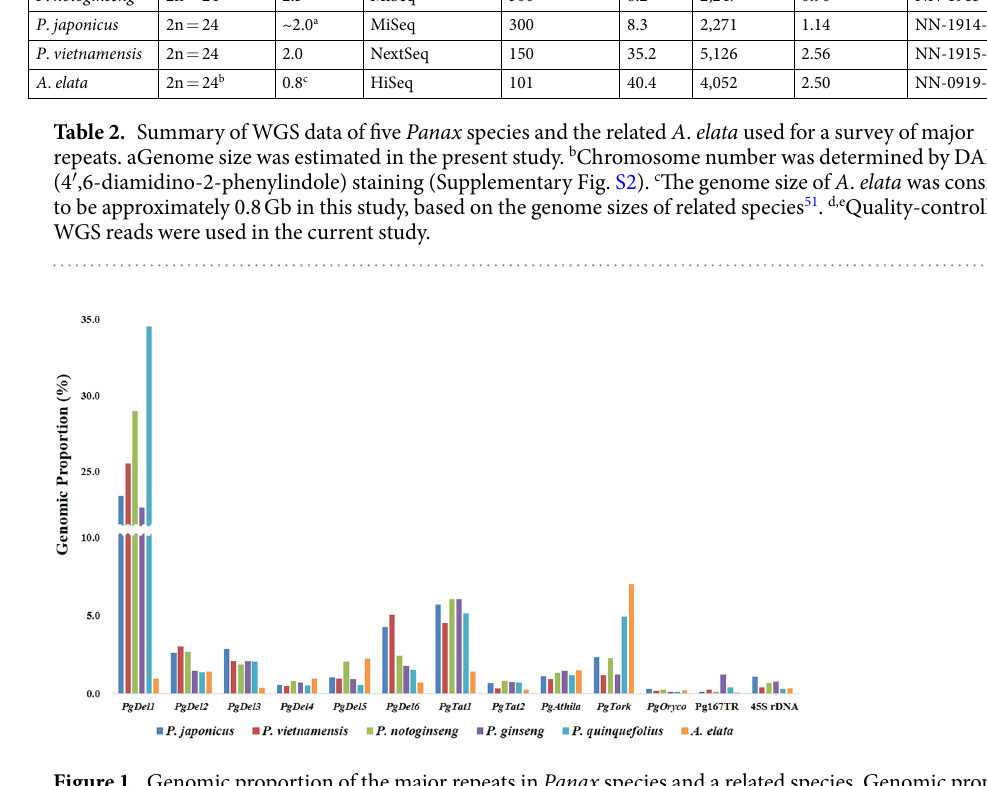
Figure 1. Genomic proportion of the major repeats in Panax species and a related species. Genomic proportion (GP) of 13 repeats in five Panax species and the related species A . elata